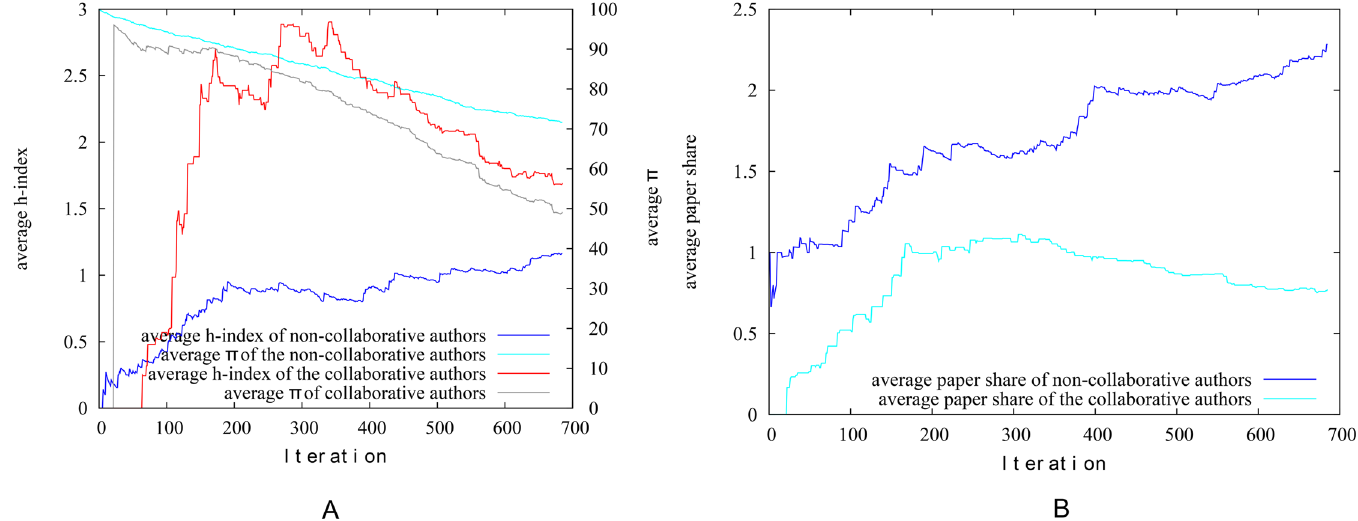
Fig 19. (A) The variation of h-index and pagerank-index for two groups of authors during the evolution of quantum game theory field. The x-axis corresponds to each new paper added and the time line of the evolution is from 1955 to 2014. One group of authors are classified as ‘ collaborative ’ and another group as ‘ non-collaborative ’ . The way this classification was done is explained in the text. It is clear that while the h-index favours the ‘ collaborative ’ authors, the pagerank-index, in general, tends to favour the ‘ non-collaborative ’ authors. (B) The average ‘ papershare ’ of collaborative and non-collaborative authors during the evolution of quantum game theory field. The ‘ papershare ’ is calculated as the summation of proportional contributions made to papers. For example, if an author has contributed two papers each with two other co-authors, he has a total of 4/3 paper-shares. It is clear that the ‘ non-collaborative ’ authors work harder and have more ‘ paper-shares ’ than collaborative authors. Contrasting with part (A), we may see that the pagerank-index highlights this fact by favouring the ‘ non-collaborative ’ authors, while the h-index arguably unfairly favours collaborative authors who on average produce less ‘ paper- shares ’